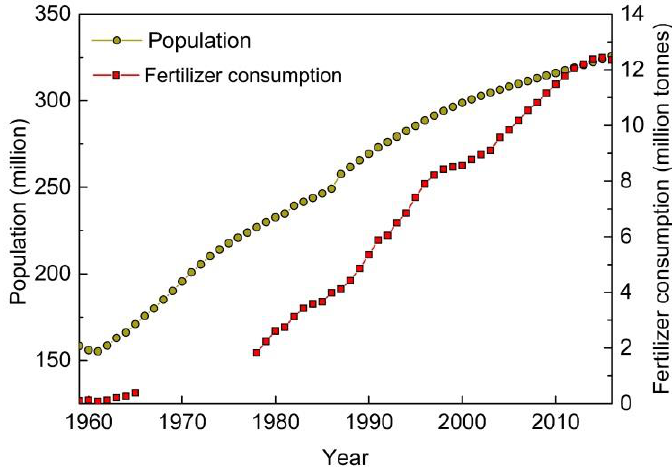
Figure 8. Variations of population and fertilizer consumption in the study area from 1959 to 2016.